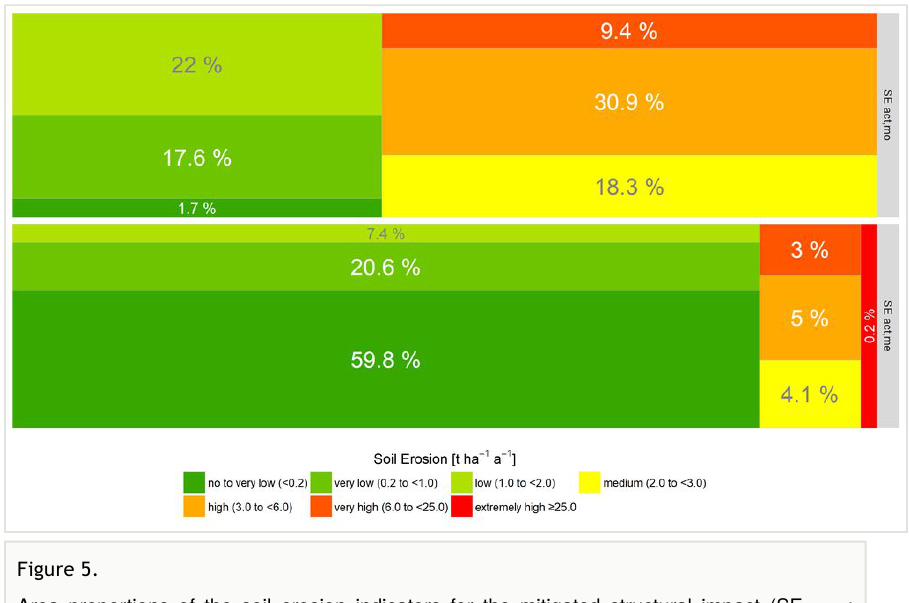
Figure 5. Area proportions of the soil erosion indicators for the mitigated structural impact (SE : based on modelled actual soil loss data; SE based on measured actual soil loss data). The treemaps visualise the proportions of soil loss classes for the whole investigation